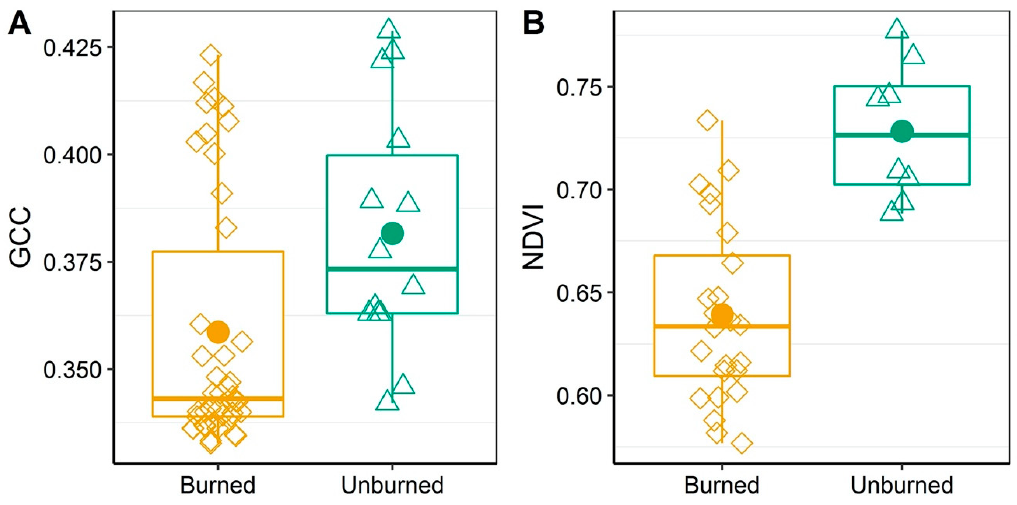
Figure 5. A comparison between burned and unburned pixels for mean GCC ( A ) and NDVI ( B ) with a 10-m buffer radius. Boxplots indicate quartile distribution with raw data for burned (diamonds) and unburned (triangles) plots. The estimated mean is the point. A Welch t-test for unequal variance was performed to test for a difference in the means of GCC ( A ) and NDVI ( B ) between burned and unburned areas. Table 7. Linear regression analyses of distance from unburned forest edge versus mean GCC or mean NDVI values using a 10-m buffer radius. Two statistical models were fit, one for GCC and one for NDVI. For each model, we report the response variable, estimates of the coefficients (ß) for the y- intercept and slope, standard error (SE), the test statistic value ( t ), p -value and adjusted R 2 . These models and raw data are visualized in Figure 6.